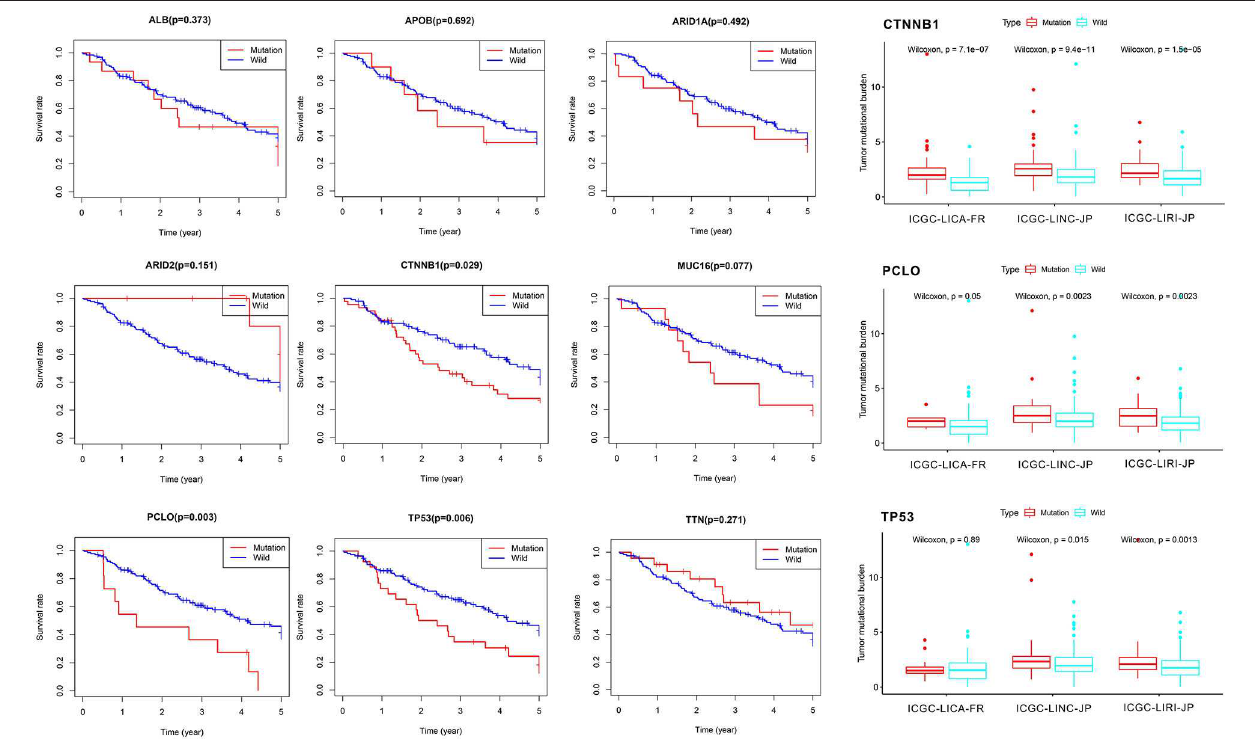
FIGURE 3 | Survival analysis and tumor mutational burden (TMB) correlation